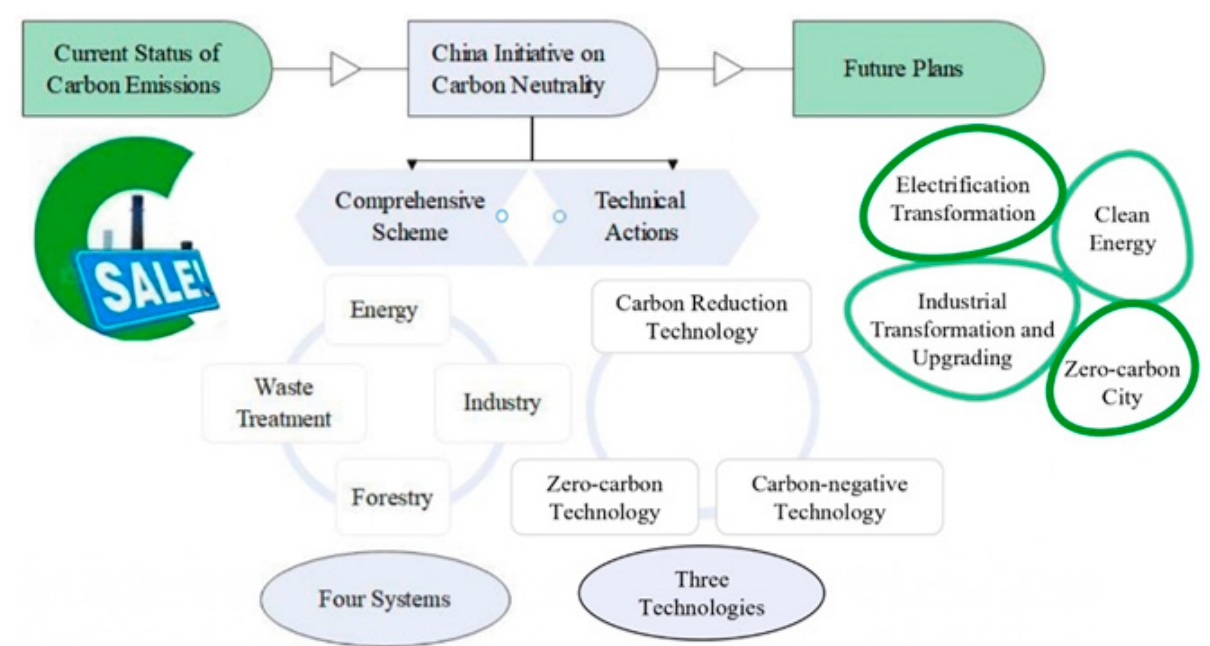
Figure 13. China’s road to carbon